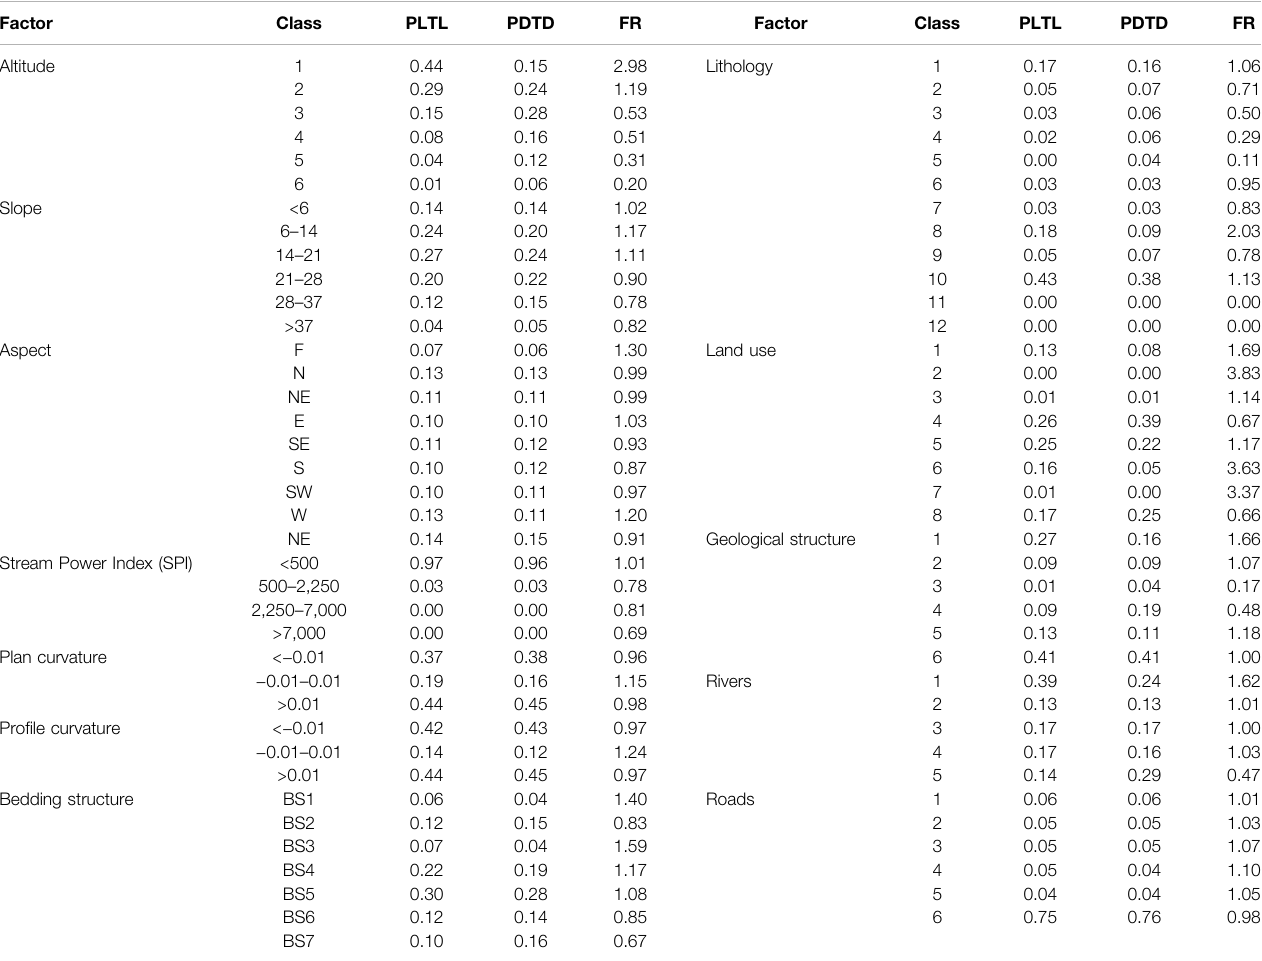
TABLE 2 | Classi fi cation and frequency ratio of the causal factors used in landslide susceptibity. Factor Class PLTL PDTD FR Factor Altitude 1